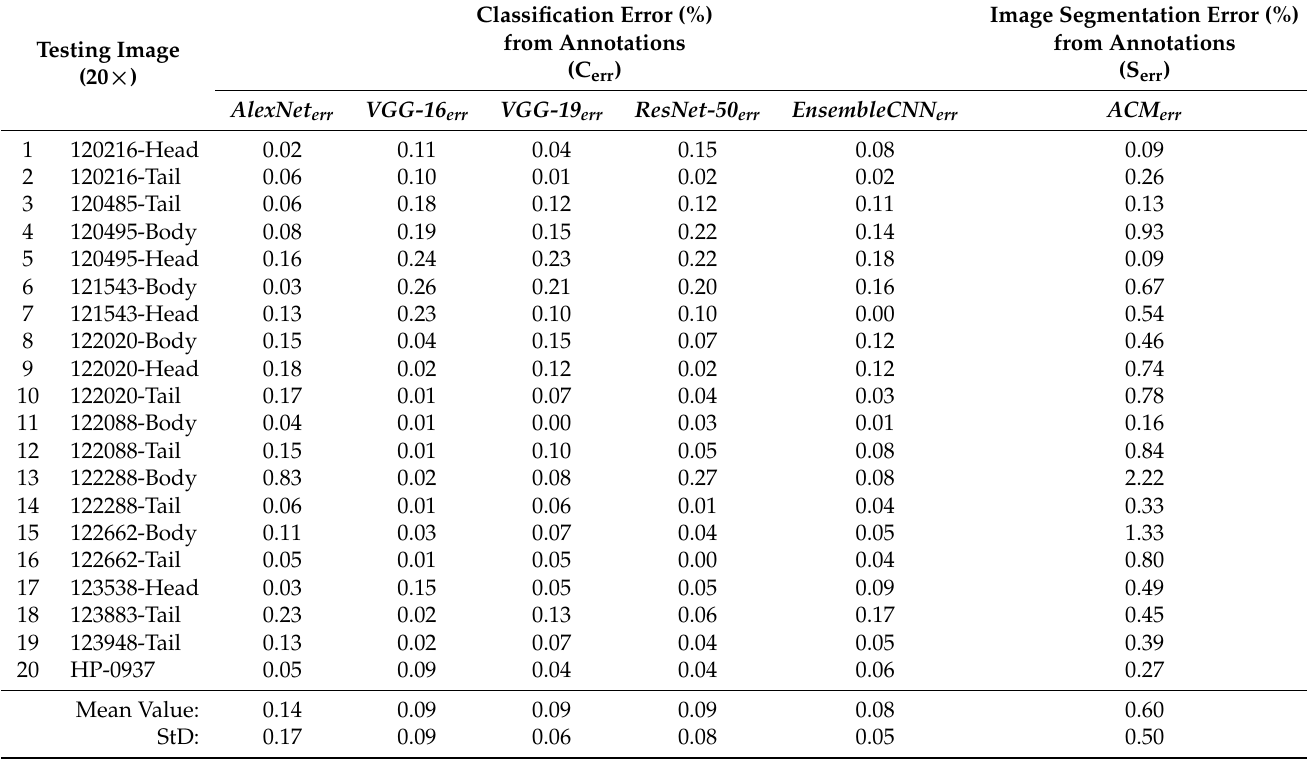
Table 5. Pancreatic fat quantification